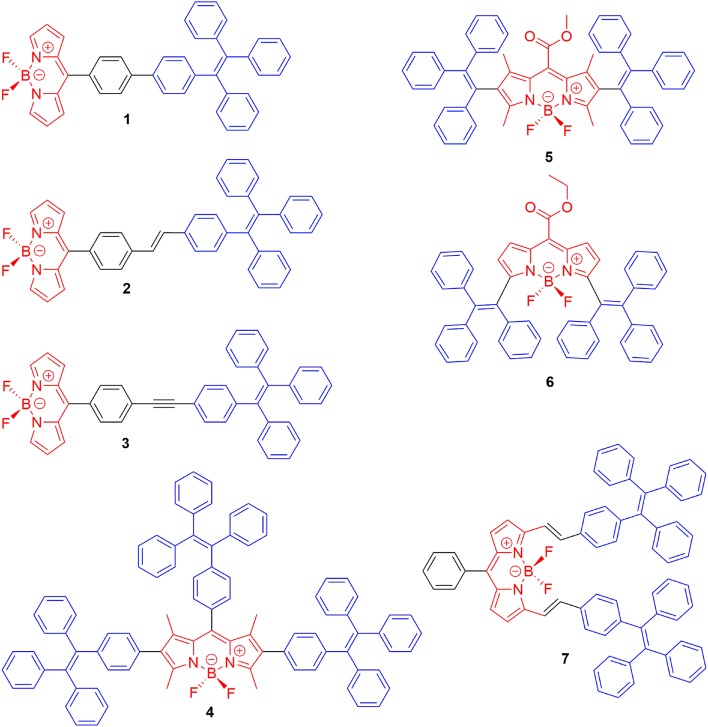
Chemical structures of compounds 1–7.